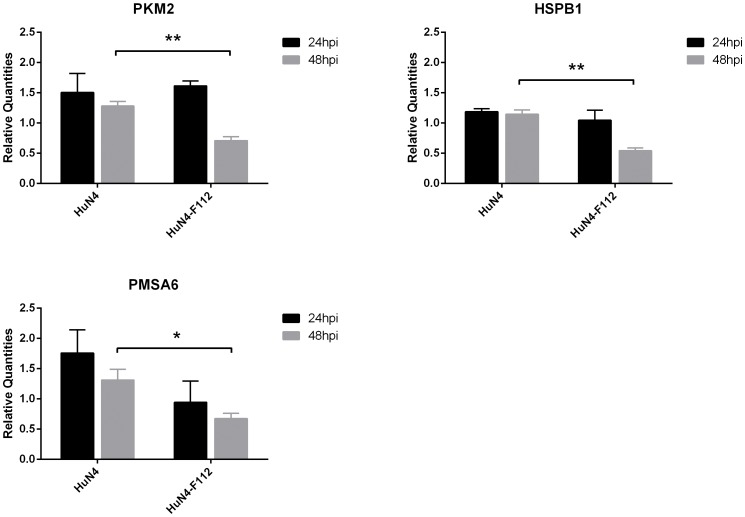
Confirmation of the transcriptional regulation of DEPs by real-time RT-PCR.Transcript alteration of three selected genes in PAM cells from the PRRSV-infected group compared with the mock-infected group. Total RNA extracted from PAM cells was measured by real-time RT-PCR analysis; relative expression levels were calculated according to the 2ΔΔCT method, using β-actin as an internal reference gene and the mock-infected group as a calibrator (relative expression = 1). Error bars represent the standard deviation. Please refer to Table 2 for the identification of gene symbols that represent different genes.